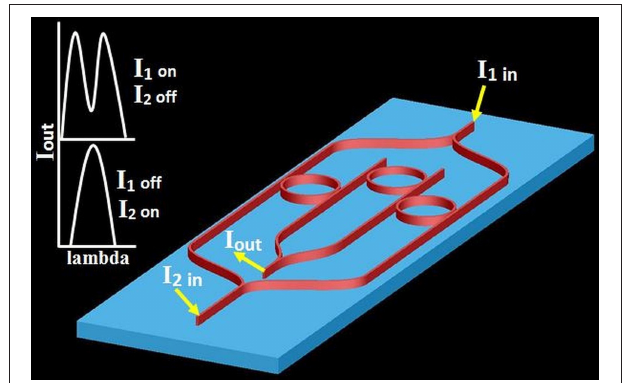
FIGURE 1 | Schematic 3D representation of the photonic switch. The figure includes the output spectral content as a function of the input state of the controlling SLD’s. The blue and red colors are shown to clearly differentiate the silicon slab (blue) from the waveguides (red). The BOX layer and SiO 2 cover layers have been omitted for model